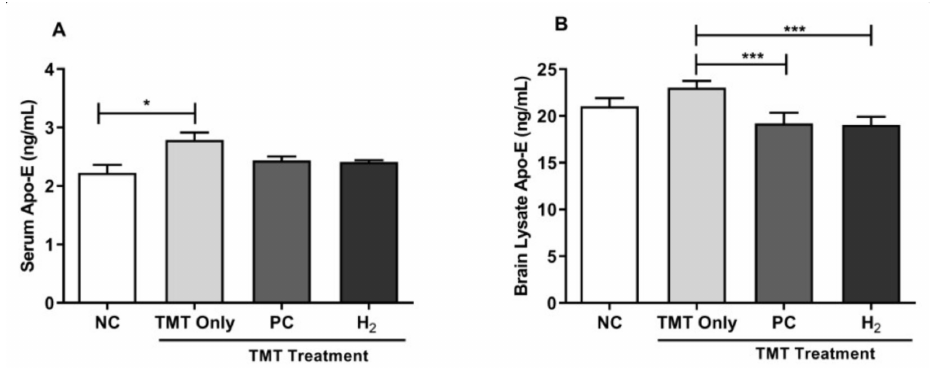
Figure 9. Effects of H 2 gas inhalation treatment on intracellular Apo-E activities in TMT-induced C57BL/6 mice after four weeks. ( A ) Serum Apo-E level, ( B ) Brain lysate Apo-E level. Data are shown as the mean ± SEM for n = 4 mice. Significant differences were analyzed with ANOVA and Tukey’s test. * p < 0.05, *** p <